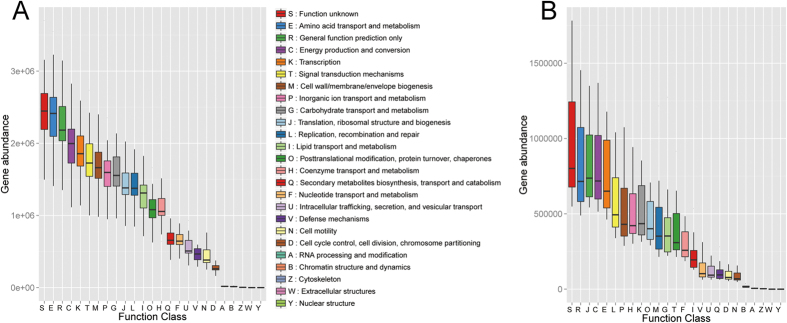
Predictive functional profiling of microbial communities using 16S rRNA marker gene sequences.A represented the function classes of bacteria and their gene abundance, while B represented that of archaea and their gene abundance.